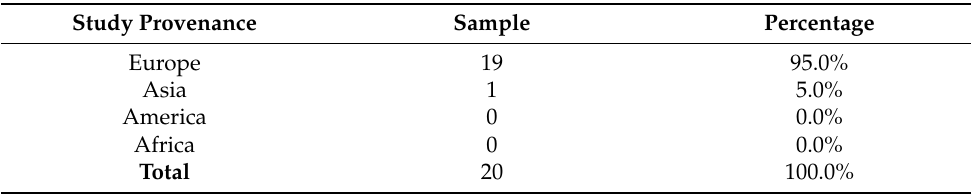
Figure 3. Distribution of the population where the selected studies are being carried out.